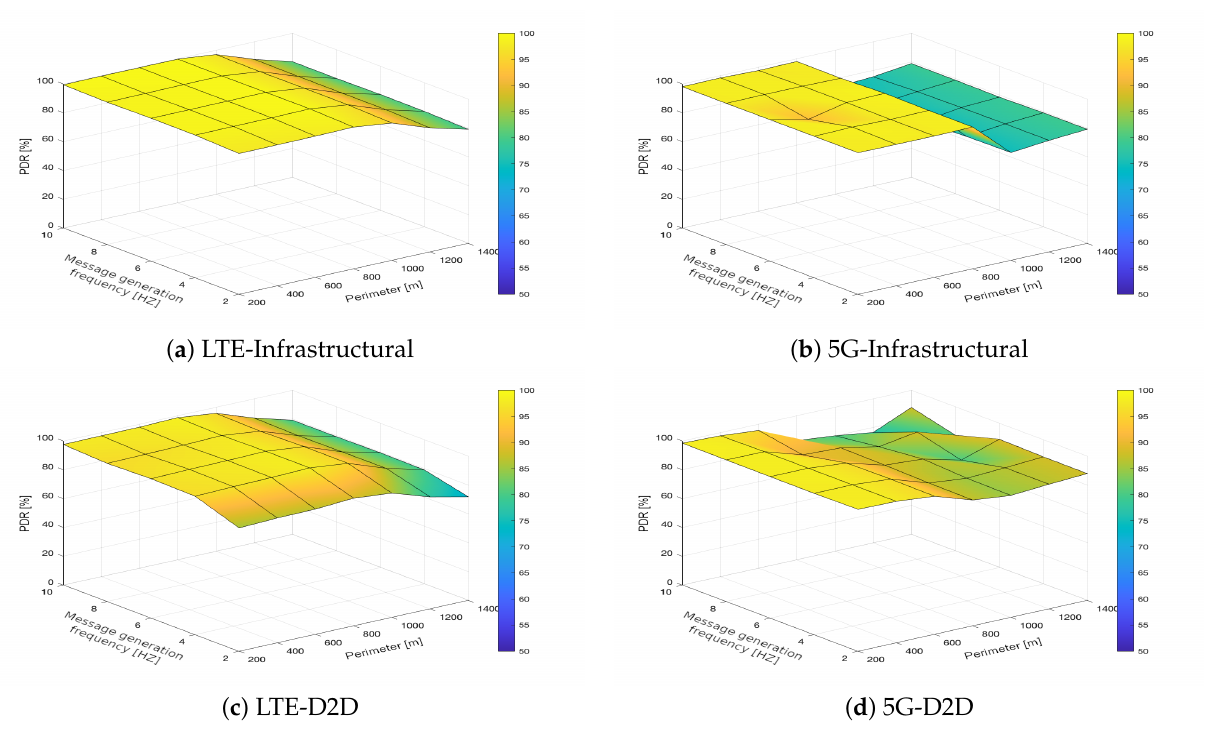
Figure 2. Packet Delivery Ratio (PDR) simulated for all the investigated modes of the 4G-based and 5G-based C-V2X technologies and traffic intensity of 250 vehicles per hour.